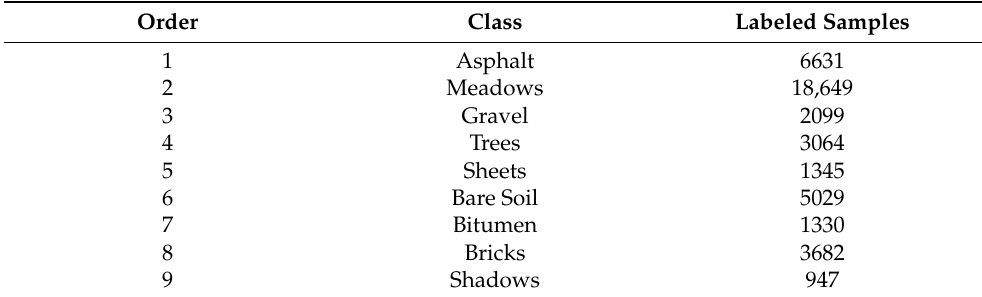
Table 3. Ground truth classes and samples of the Pavia University dataset.